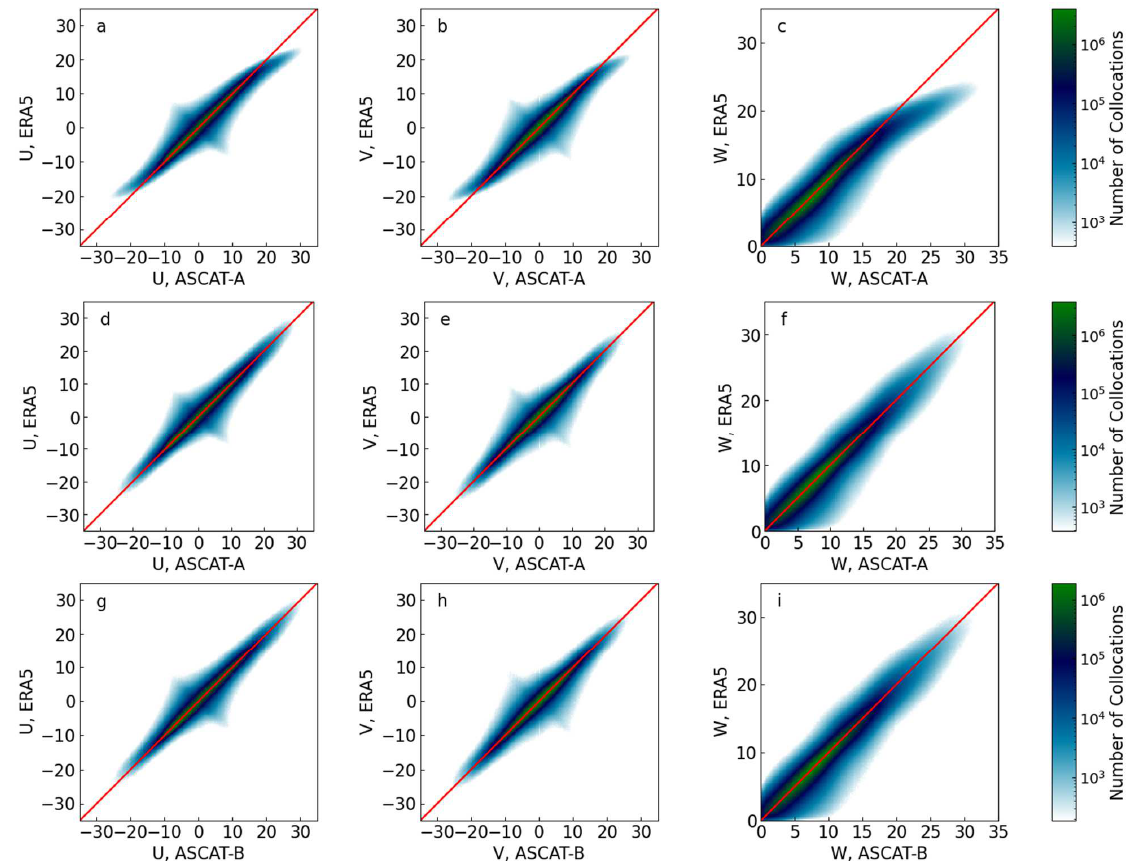
Figure 6. Two-dimensional histograms of ERA5 winds as a function of scatterometer winds. The top row ( a – c ) shows the results using unadjusted ERA5 neutral stability winds and ASCAT-A winds. The second row ( d – f ) shows the results for ERA5 and ASCAT-A winds after the adjustment for ocean currents, speed adjustments and vector components were applied. The bottom row ( g – i ) is similar to the middle row, except for collocations with ASCAT-B winds were used. Note that ASCAT-B results were not used to derive any of the adjustments, confirming that the adjustments applied to ERA5 are not idiosyncratic differences arising from features of a single instrument.